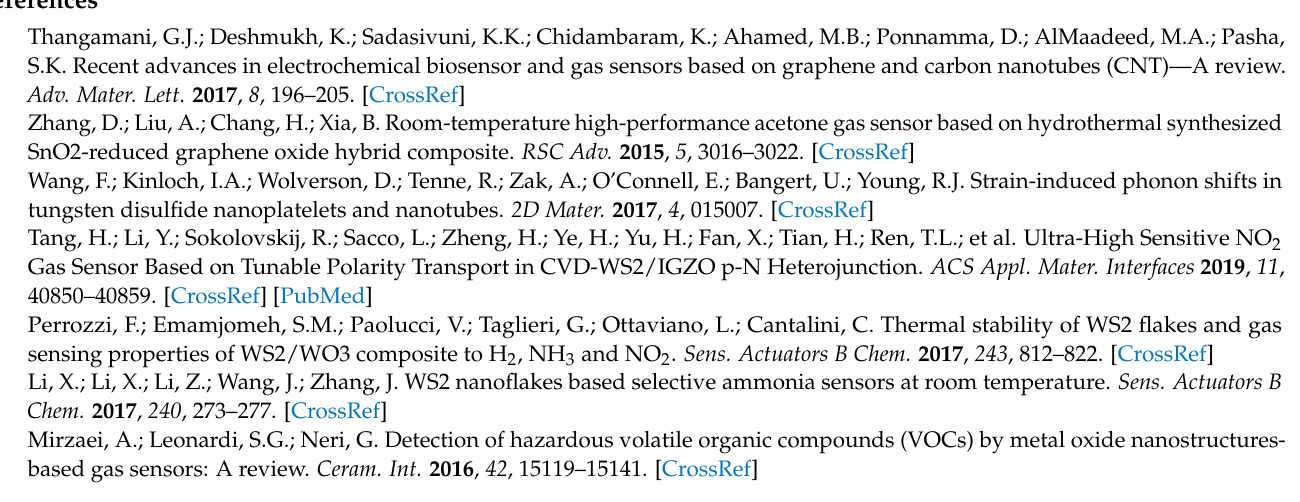
Figure S5: Histogram of comparison between Methanol, Toluene and Butanol gas at five different concentrations, Figure S6: Low concentration response comparison between Butanol, Methanol and Toluene VOC gas, Figure S7: Selectivity calibration curve between Methanol, and Toluene VOC gas, Table S1: Response time for the all the different